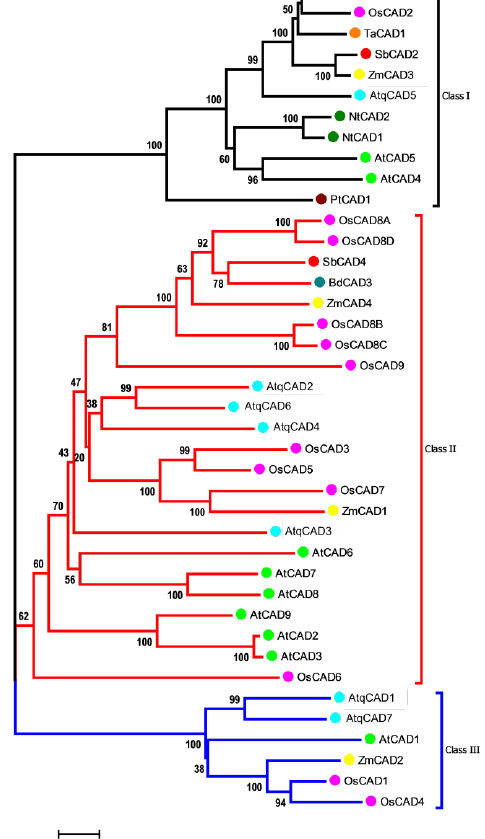
Figure 6. Unrooted phylogenetic tree of the CADs from Agave tequilana (AtqCAD), Zea mays (ZmCAD), Oryza sativa (OsCAD), Sorghum bicolor (SbCAD), Nicotiana tabacum (NtCAD), Pinus taeda (PtCAD), Brachypodium distachyon (BdCAD), Triticum aestivum (TaCAD), and Arabidopsis thaliana (AtCAD). 2.4. Retrieved Agave Orthologous Genes for Cellulose and Lignin Biosynthesis Are Preferentially Expressed in Cells Surrounding Leaf Sclerenchyma Fibers